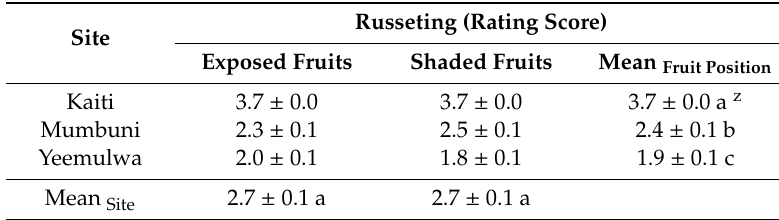
Table 3. Russeting of peripheral (exposed) or central (shaded) ‘Apple’ mango fruit in the canopy at three di ff erent sites. The sites were selected because they di ff er in elevation. Russeting was quantified using a five-score rating scheme. Score 0: 0% of the fruit surface area russeted; score 1: 1–10% russeted area; score 2: 11–25% russeted area; score 3: 26–50% russeted area; and score 4: 51–100% russeted